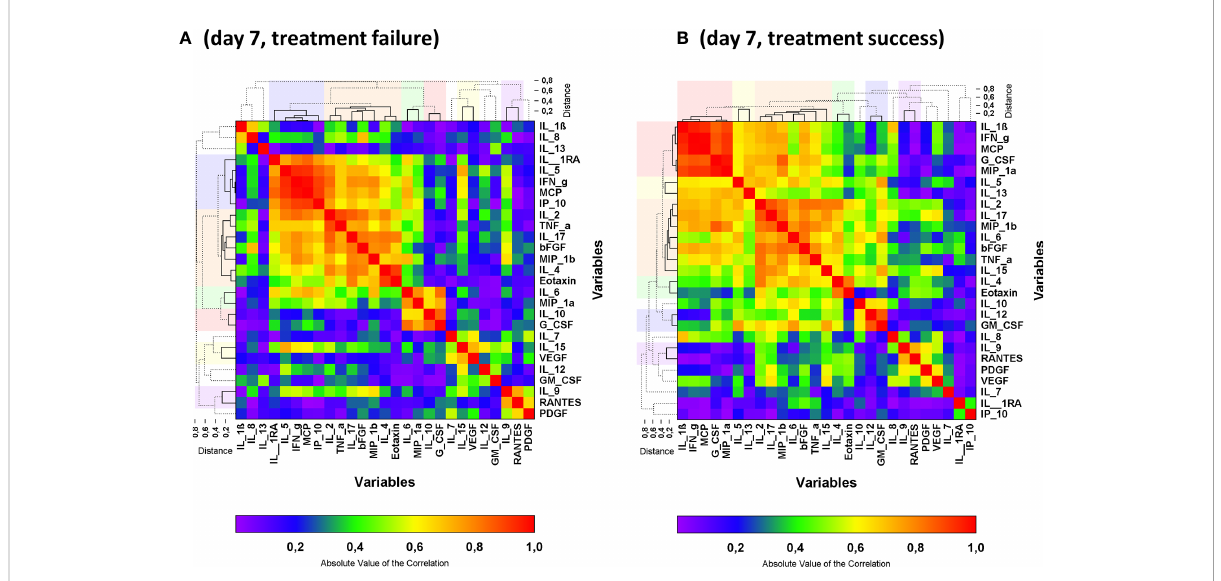
FIGURE 4 Heat map of the absolute values of the correlation matrix on day 7 in an analysis including both control group and CCP group strati fi ed by reaching the primary endpoint on day 21: failure (A) and success (B) . Clustered cytokines are indicated by the solid lines in the dendrograms and the clusters are indicated by the colors above and beside the graph. Non-clustered cytokines are shown by the dashed lines in the dendrogram. Clusters were formed by the unweighted group method. Cluster reports for the absolute values of the correlation matrix are presented in Table